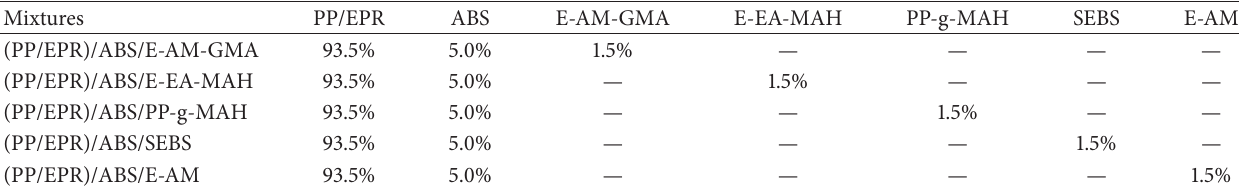
Table 4: Composition of blends (PP/EPR)/ABS/compatibilizer at a rate of 1.5% of one of the five compatibilizers.